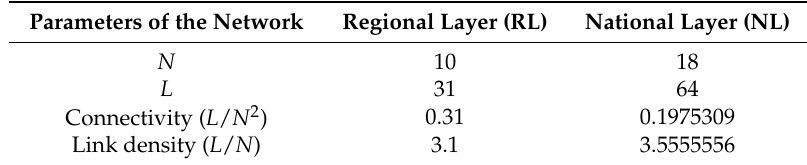
Table 2. The connectivity and link density of the two models at different layers. Parameters of the Network Regional Layer (RL) National Layer (NL) Parameters of the network Regional layer (RL) N